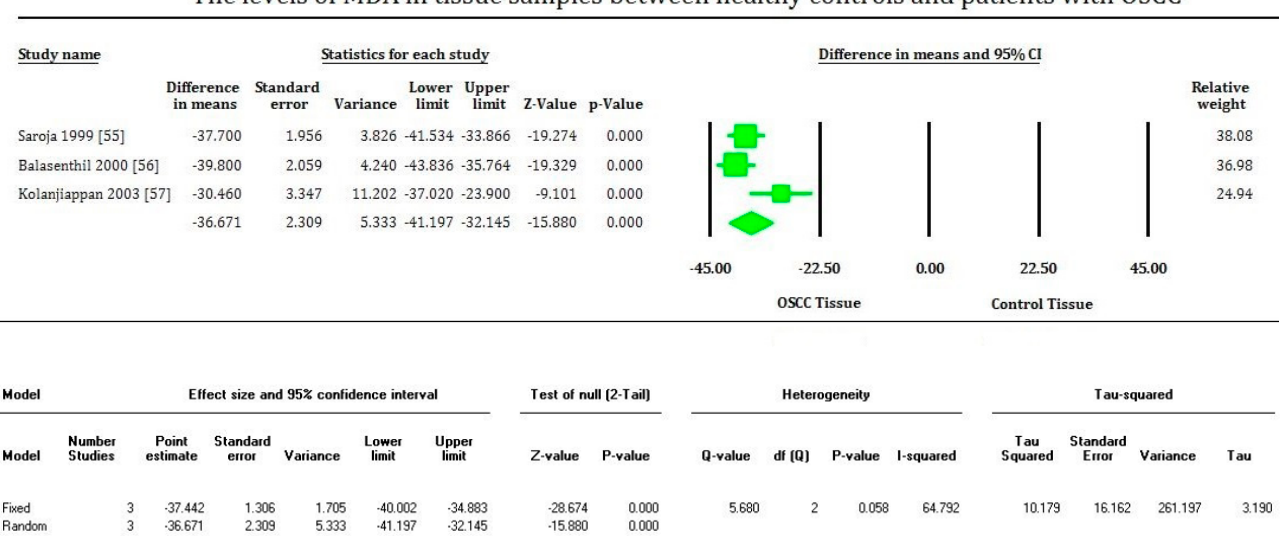
Figure 5. Forest plot shows mean difference estimates with 95% confidence intervals representing differences in tissue levels of MDA between oral squamous cell carcinoma group and healthy controls.